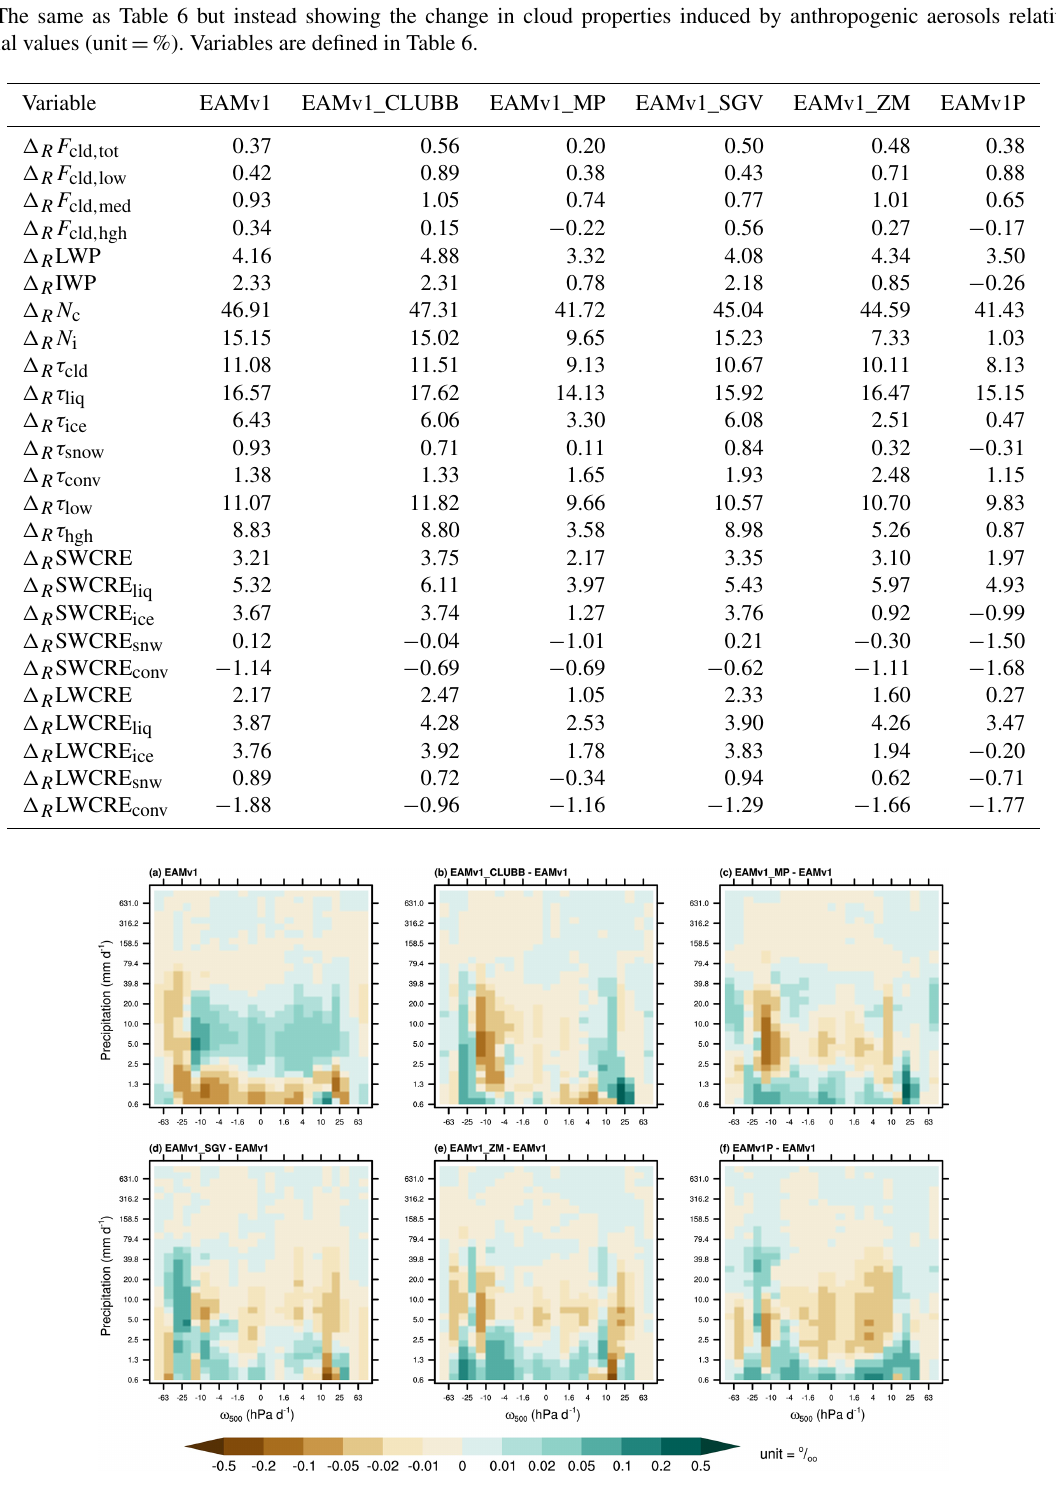
Figure 16. Anthropogenic aerosol-induced change in frequency of occurrence of resolved-scale precipitation as a function of vertical velocity at 500hPa (unit = hPad − 1 ) in (a) EAMv1 and differences between (b) EAMv1_CLUBB and EAMv1, (c) EAMv1_MP and EAMv1, (d) EAMv1_SGV and EAMv1, (e) EAMv1_ZM and EAMv1, and (f) EAMv1P and EAMv1. Model precipitation rates are sampled at every model time step (d t =